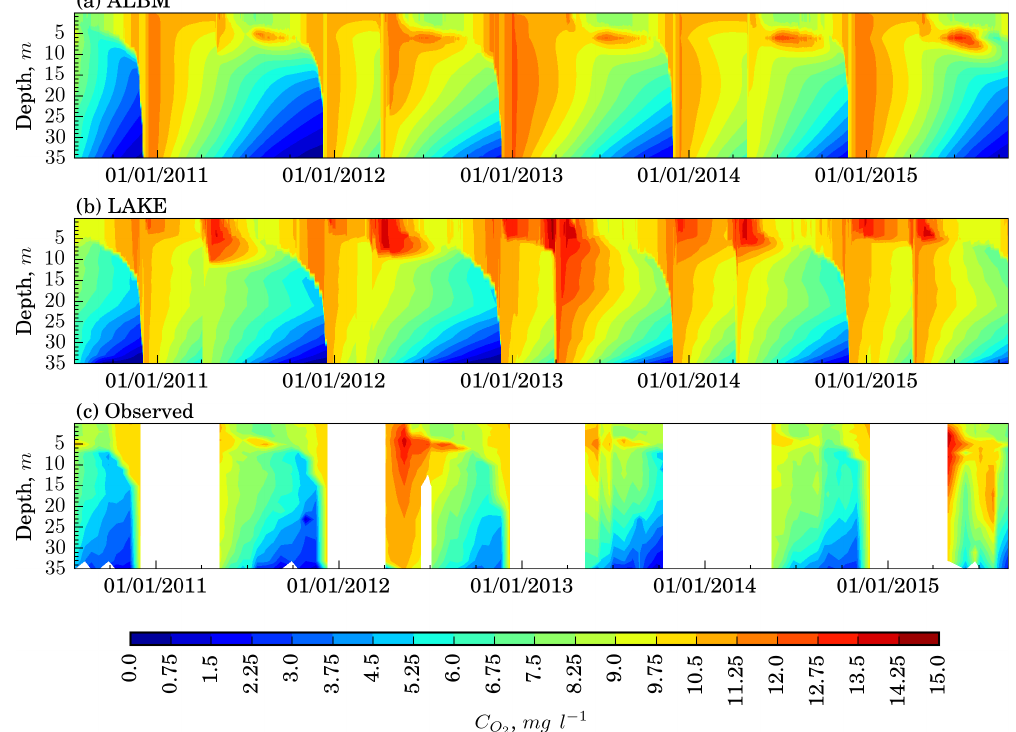
Figure 7. Time–depth profiles of O 2 in Harp Lake (14 July 2010–19 October 2015) and model experiment including sediments and mor- phometry (GasSim) for (a) ALBM and (b) LAKE. White patterns in (c) indicate absence of data.